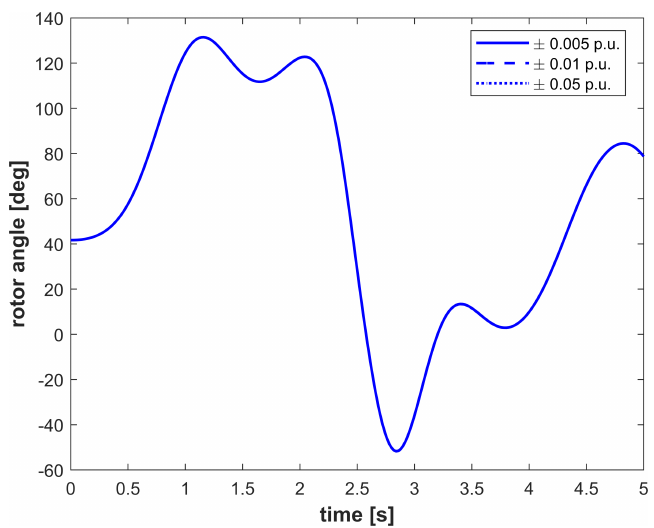
Figure 18. Rotor angle of the Termini Imerese (Sicily) generator with different control variable discretization